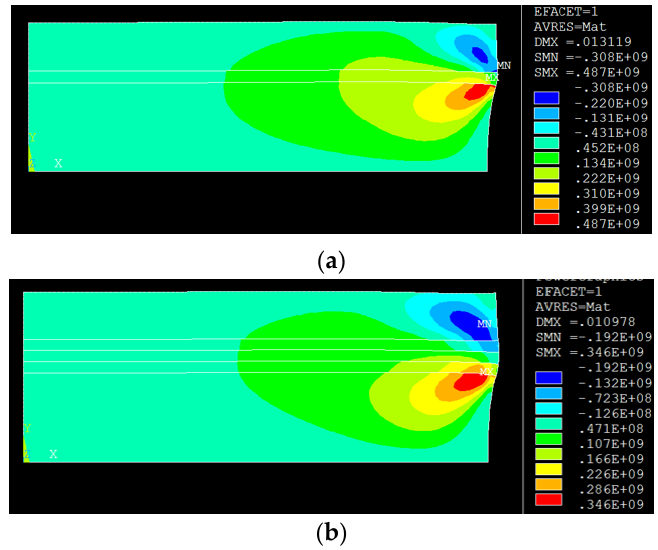
Figure 6. Shear stress distribution of the composite ceramic panels: ( a ) with a single magnetic interlayer; ( b ) with a three-layer gradient.